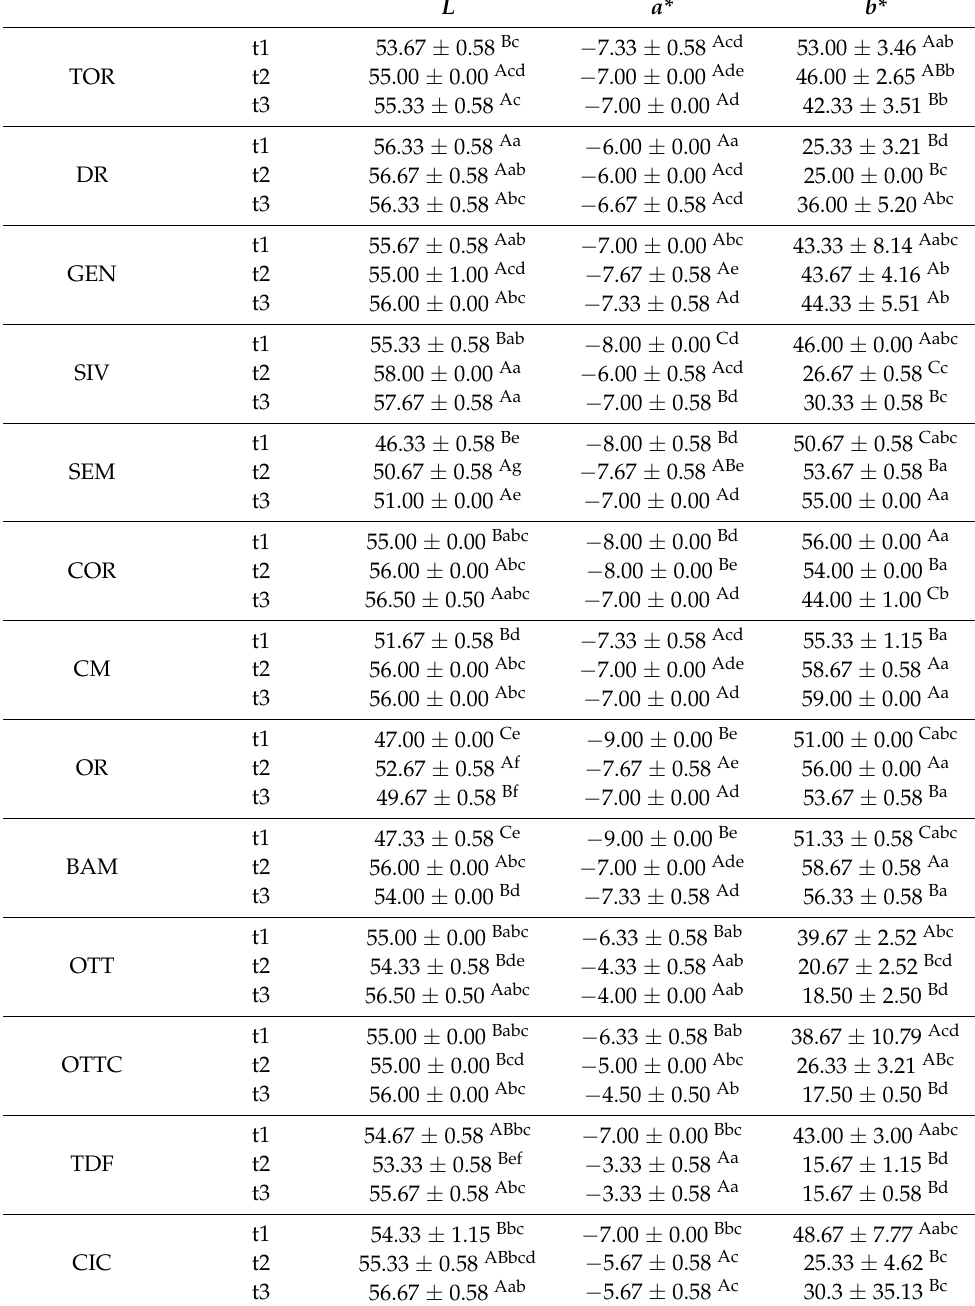
Table 5. Color parameters of 13 minor Italian olive oils harvested at three maturation stages 1